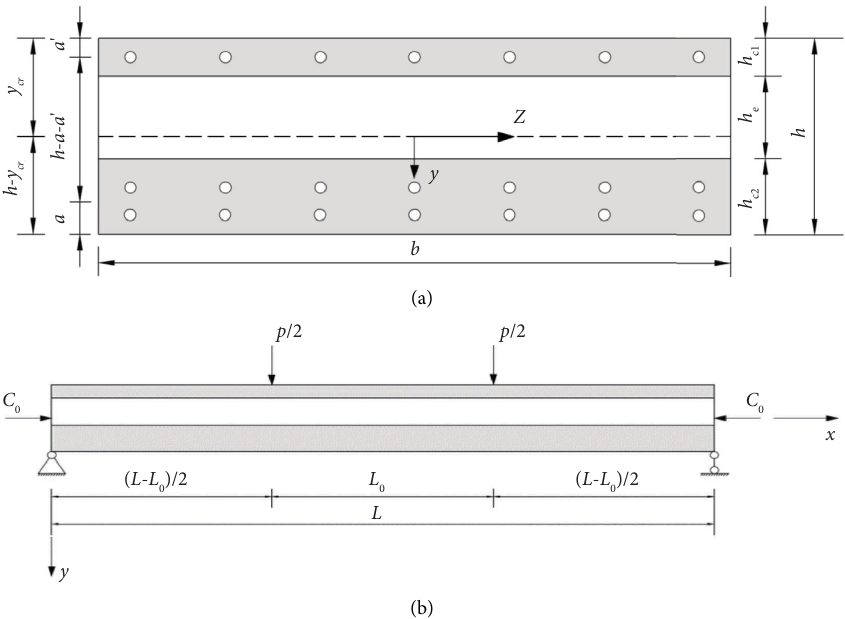
Figure 18: Coordinate system. (a) Cross section of sandwich panel and (b) side view of sandwich